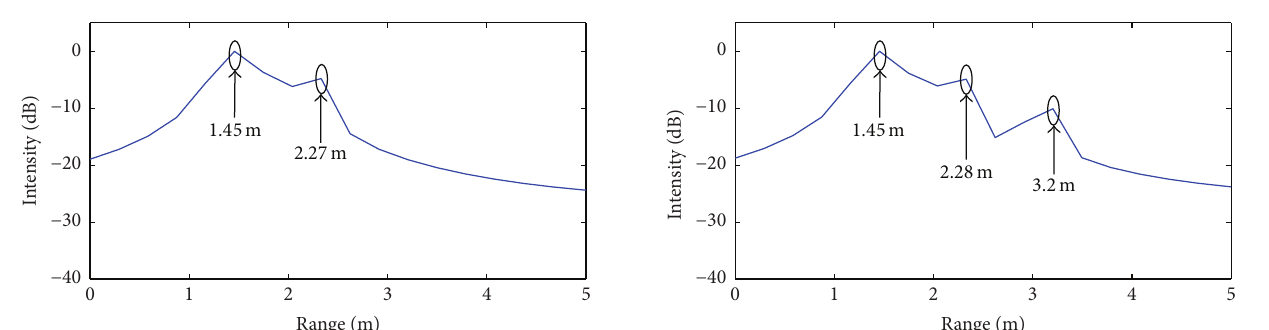
Figure 6: Range profile obtained from standard IFT algorithm (first scenario: 𝑁 = 4 targets).